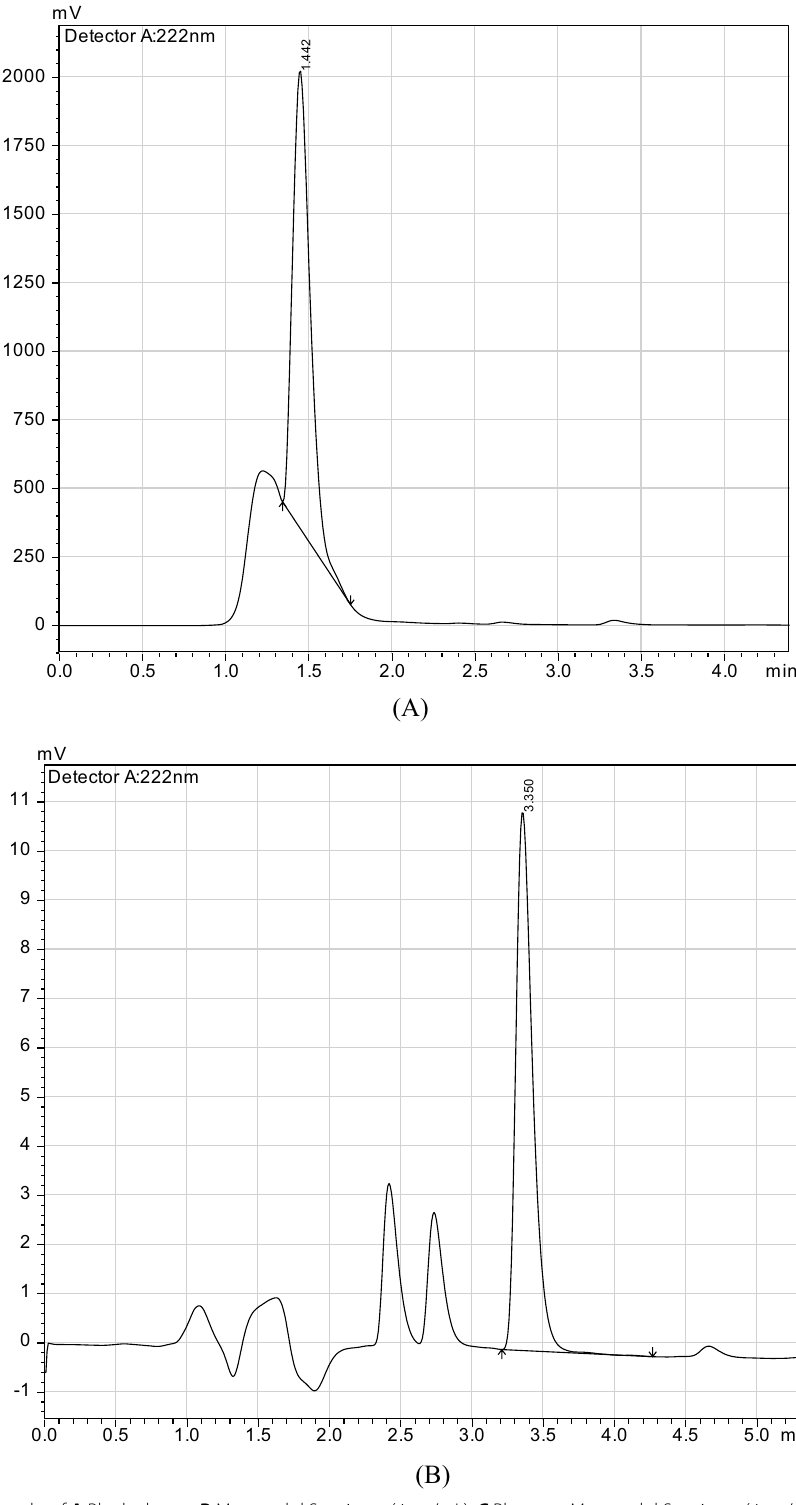
Metoprolol Succinate (4 +